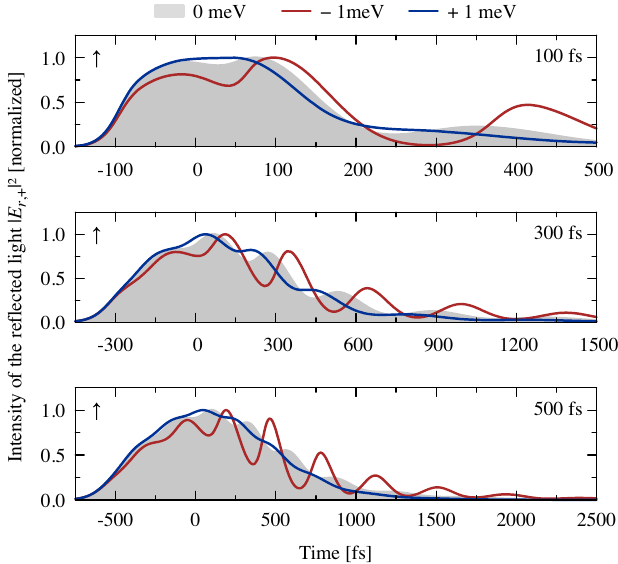
FIG. 4. Normalized time-dependent intensity of the reflected t Þj 2 for a monolayer of MoS 2 at 5 K for different light j E r; þ ð detunings of the laser energy ℏ ω with respect to the exciton p − ϵ 0 , − 1 , and þ 1 meV. The intensity energy ϵ : ℏ ω x; þ p x; þ ¼ FWHM of the different linearly ( ↑ ) polarized pulses with fixed pulse area Θ ¼ 2 π is